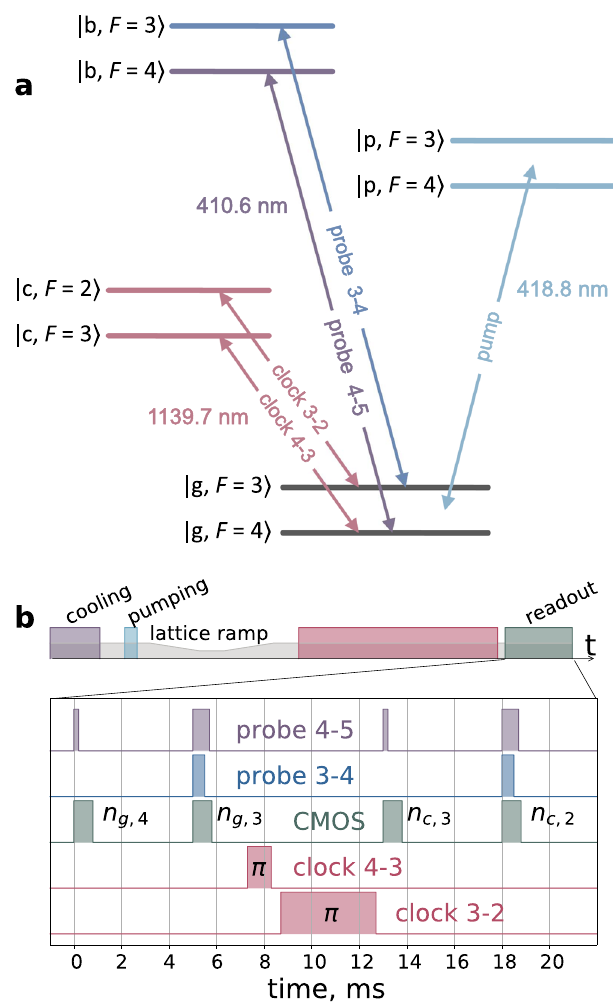
Fig. 5 Readout protocol. a Relevant thulium level scheme. The “ pump ” radiation is detuned by − 175 MHz from the g ; F ¼ 4 j